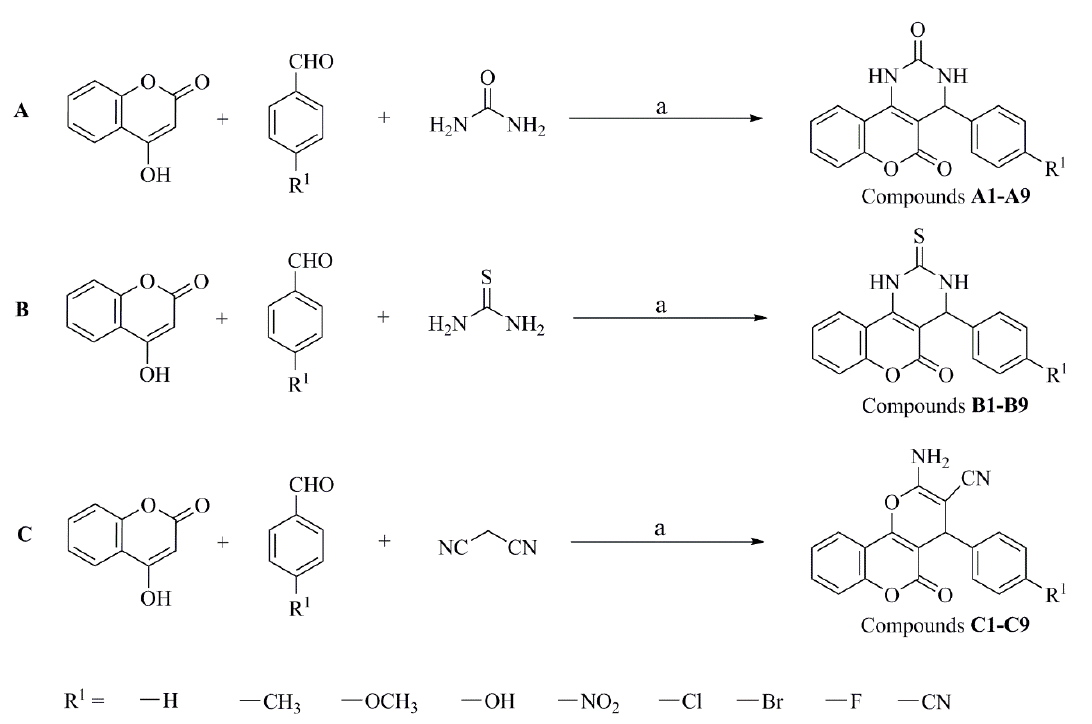
Figure 8. Synthetic route of coumarin derivatives A1 – 9 , B1 – 9 , and C1 – 9 . Reagents and conditions: (a) 0.1 M SLS, H 2 O, 60–65 °C, 5 h.